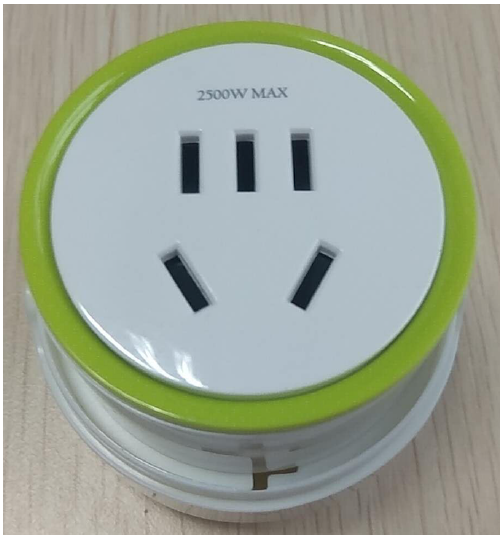
Figure 6. Konke’s smart